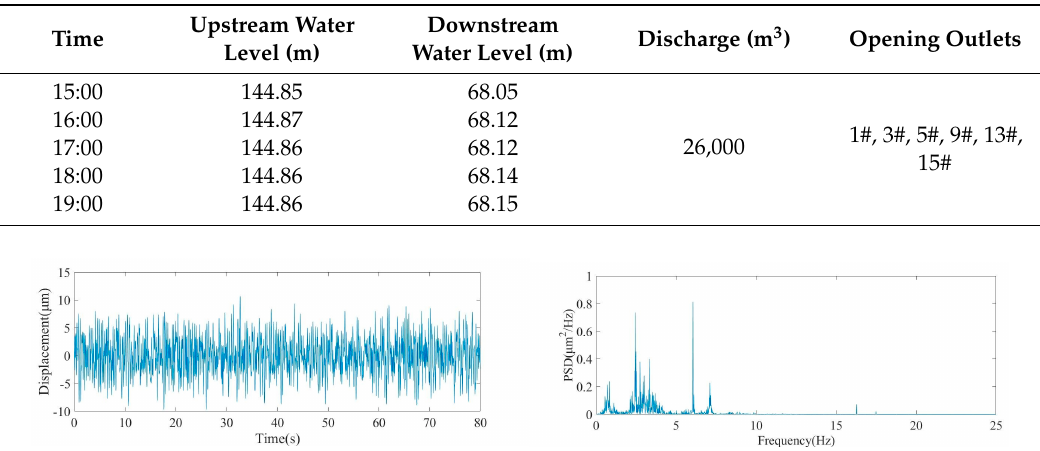
Figure A1. The time-history and Fourier Transform (FT) spectrum of horizontal displacement on 1# dam block.